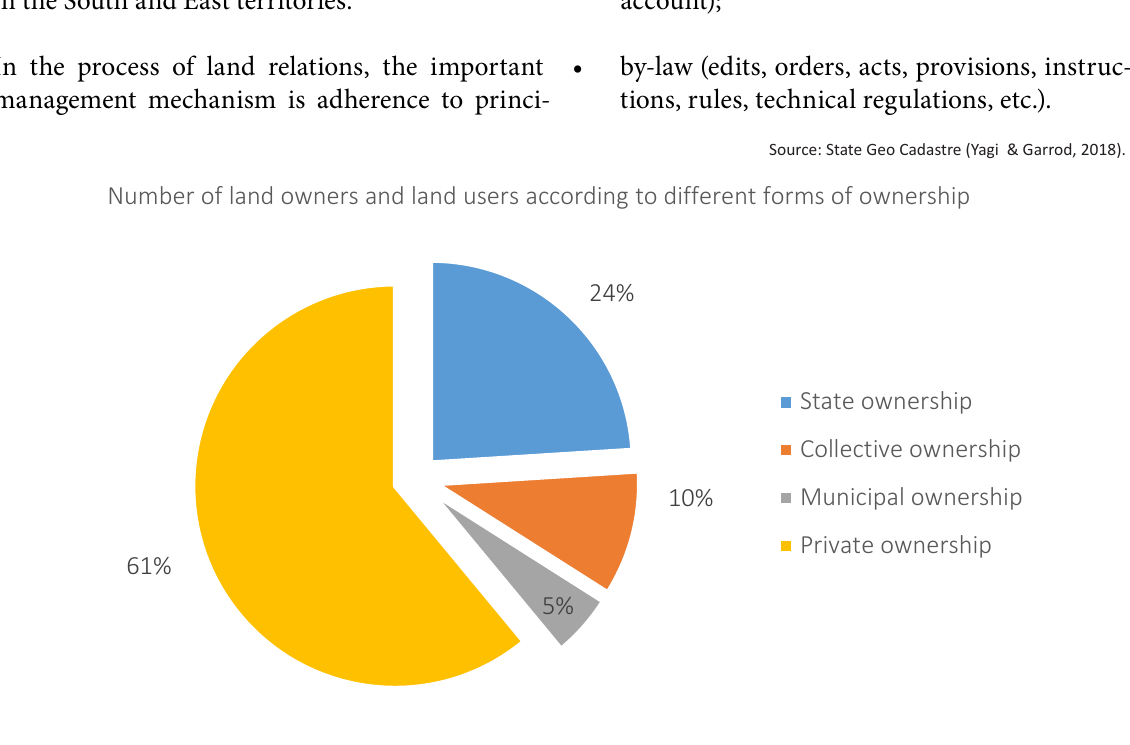
Figure 2. Analysis of land plots owners and users in